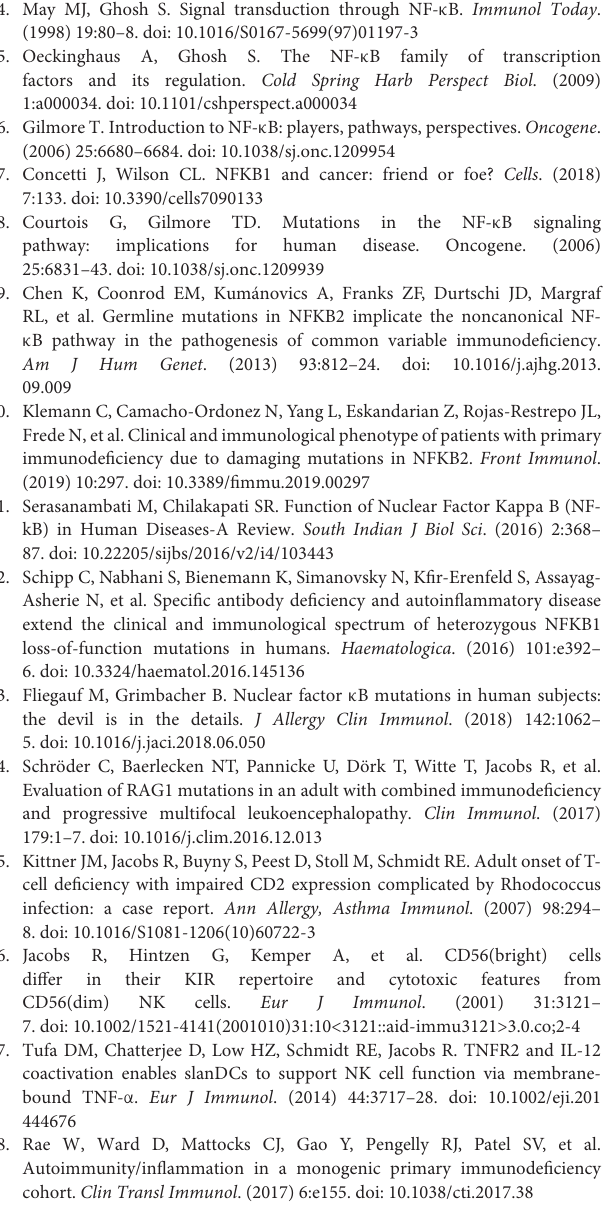
Supplementary Table 1 | Genes included in the NGS panel. Supplementary Table 2 | Primers used for Sanger